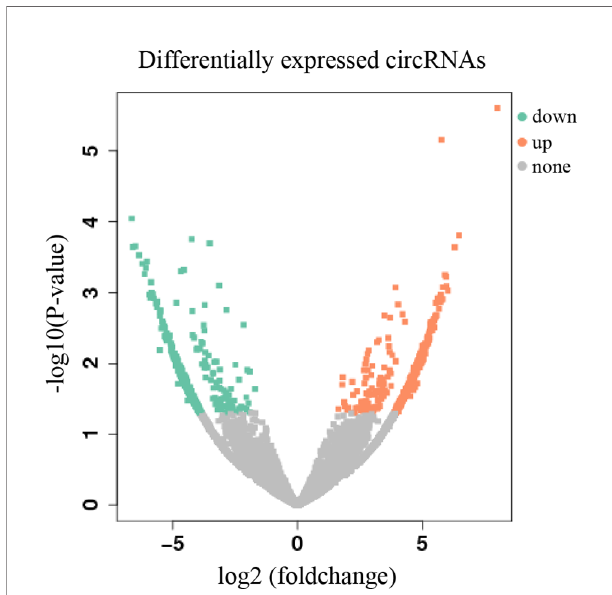
FIGURE 1 | Volcano plot of differentially expressed circRNAs. The abscissa is log2 (foldchange), and the ordinate is -log10 (p-value). The orange dots in the upper right corner indicate up-regulated genes, and the green dots in the upper left corner indicate down-regulated genes. The grey dots at the bottom represent genes that were not signi fi cantly differentially expressed.